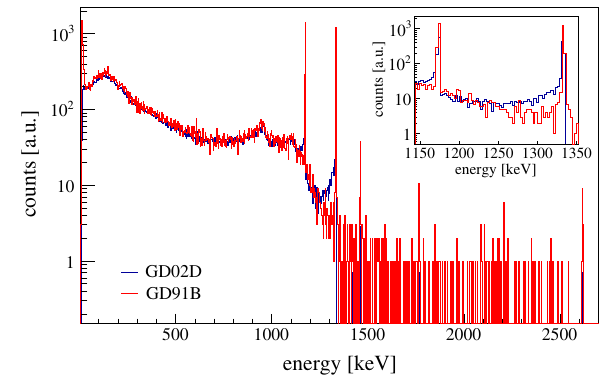
Fig. 11 Energy spectra of the 60 Co source measurements performed with the detectors GD02D and GD91B Table 4 Comparison of GD02D with GD91B: count rates in different peaks and energy regions. The measurement time of GD02D was nor- malized to the measurement time of GD91B, and the count rates scaled accordingly ID Energy